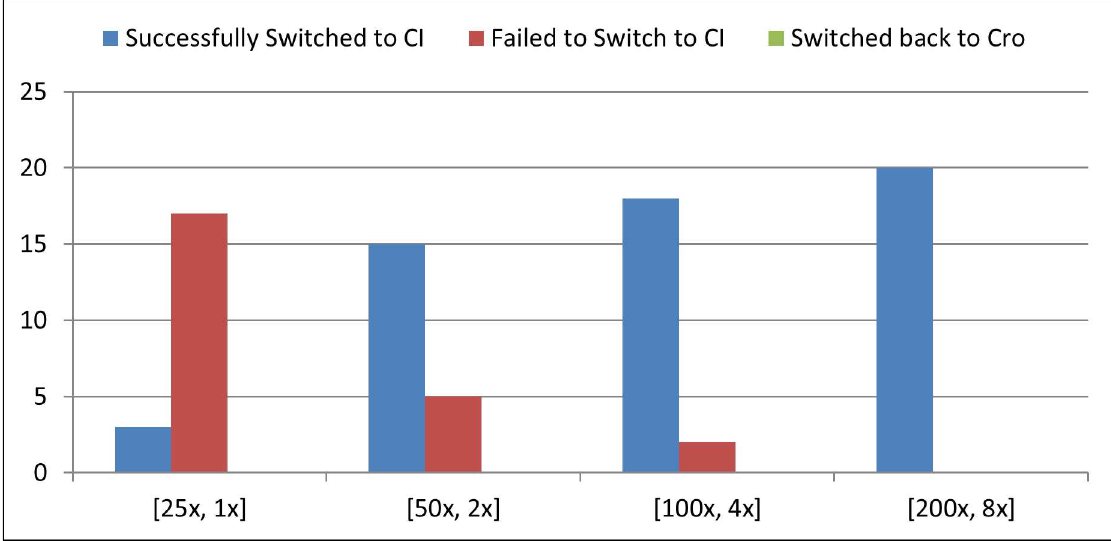
Fig 6. Success rate of switching the memory device ON. Each simulationwas run 20 times with different [RBS1, RBS2] ratios: [25x,1x], [50x,2x], [100x,4x] and [200x,8x] where 25x means the RBS is 25 times stronger than the RBS in wild type cI .